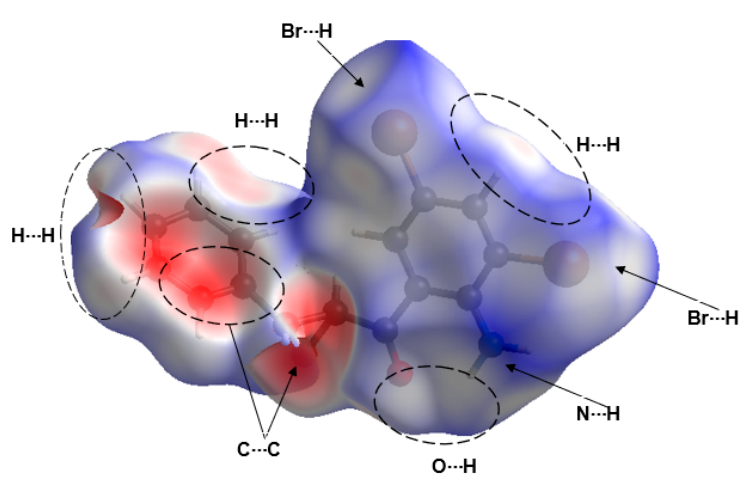
Figure 8. Two-dimensional fingerprint plots showing the highest interactions of 2a . d i corresponds to the closest internal distance from a given point of the HF surface, and d e to the closest external contacts (i.e., external distance). The difference in energy between the HOMO (highest occupied molecular orbital) and LUMO (lowest unoccupied molecular orbital) is an important quantitative structure–activity relationship (QSAR) descriptor and has also been found to relate to molecular reactivity [35]. The electron distribution of 2a was scattered in the HOMO over the epoxy ortho -aminoketoaryl moiety excluding the bromine atoms, whereas the LUMO was mainly disseminated over the entire ortho -aminoketoaryl group (Figure 9). The frontier molecular orbital energy gap between the HOMO ( − 0.229 eV) and the LUMO ( − 0.089 eV) of 2a was found to be 0.14 eV. This high energy gap value may suggest high chemical stability and high excitation energy for this molecule.